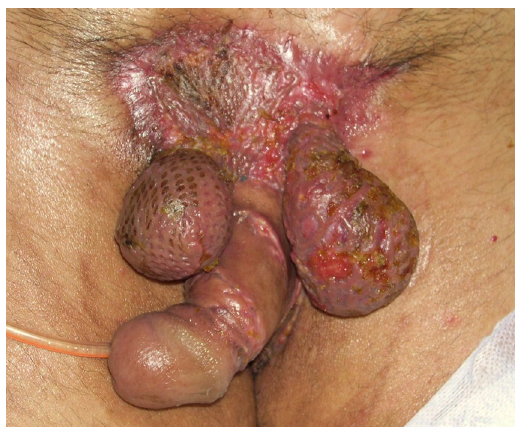
Figure 3: Example of using mesh grafting around the testicles and in the pubic area: unsightly and non - functional result with the risk of daily testicular traumatism.